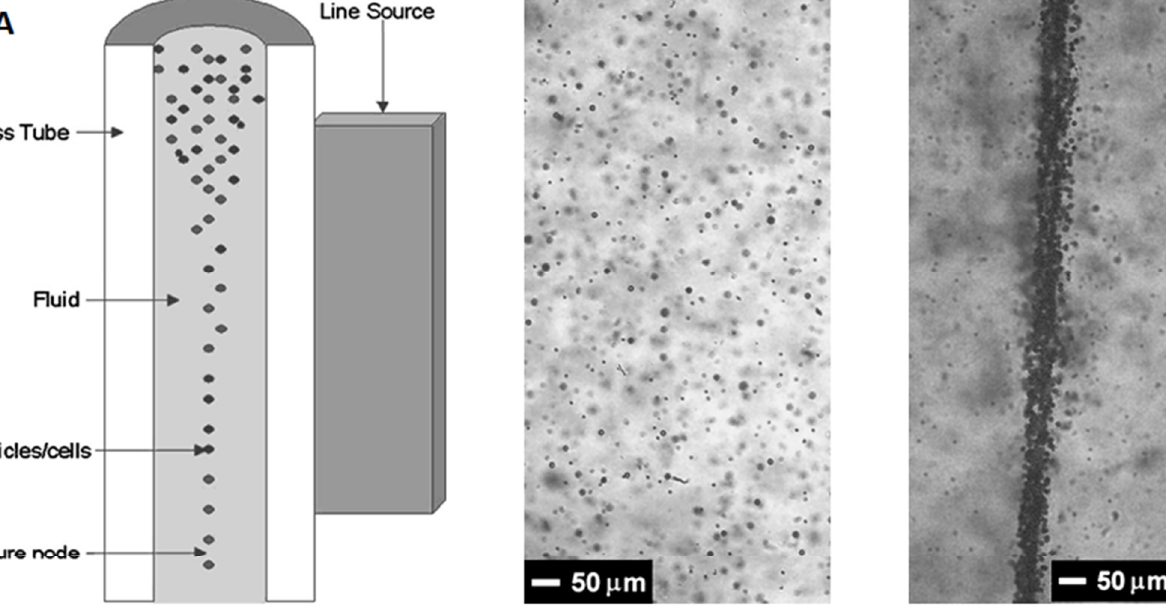
Figure 9. Acoustic focusing of microparticles in circular cross-section glass capillaries. ( A ) Ultrasonic microparticle con- centration in a soft glass capillary ( 𝑑 = 2.2 mm). Reprinted with permission from [61] . ( B ) In vitro and in vivo ultrasonic focusing of cells. In vitro ( left ): acoustic focusing of blood cells was performed in a circular quartz capillary ( 𝑑 = 0.1 mm). In vivo ( right ): acoustic cell focusing in blood in a mouse ear vessel and acoustic focusing of cells (WBCs) in a 180 μ m diameter mouse mesenteric lymph vessel. Reprinted with permission from [65] . Recently, Lei et al. [66] reported a 2D ultrasonic particle focusing device consisting of two orthogonally placed PZTs and a circular cross-section glass capillary ( 𝑑 = 0.9 mm), shown schematically in Figure 10A. To make the most of orthogonally ultrasonic excita- tions, a circular glass capillary with a square outer cross-section was designed. It was shown that a nearly uniform distribution of acoustic radiation force field was obtained when two orthogonal (1, 0) modes were generated in cross-section of the channel and the efficiency of particle concentration was much improved when compared to the excitation of a single PZT. It was demonstrated that 2D focusing of 10 μ m polystyrene particles was achieved for flow rate up to 400 μ L/min. Later, Lei et al. [67] designed a dual 67.5° prisms method to characterize 3D microparticle acoustophoresis in circular cross-section glass capillaries. The working mechanism is presented in Figure 10B, which shows that micro- particle acoustophoresis on both horizontal and vertical planes of the fluid channel can be